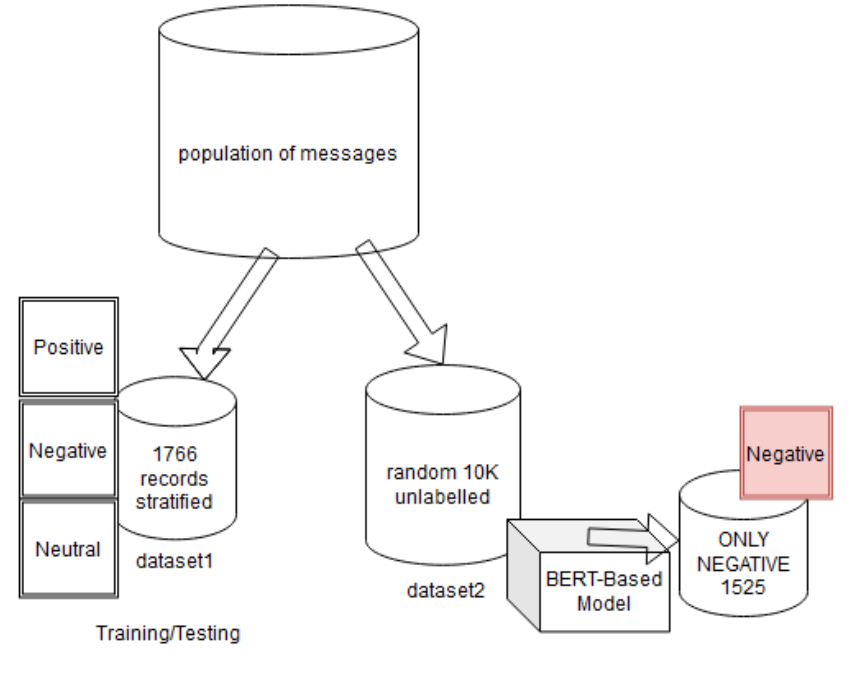
Figure 3. Datasets used in the